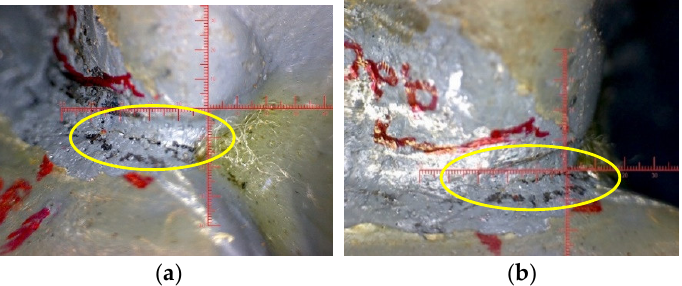
Figure 8. Diagram of fatigue cracks of south side of the CB/SB3 joint. ( a ) 3.2 million cycles. ( b ) 4.0 million cycles.